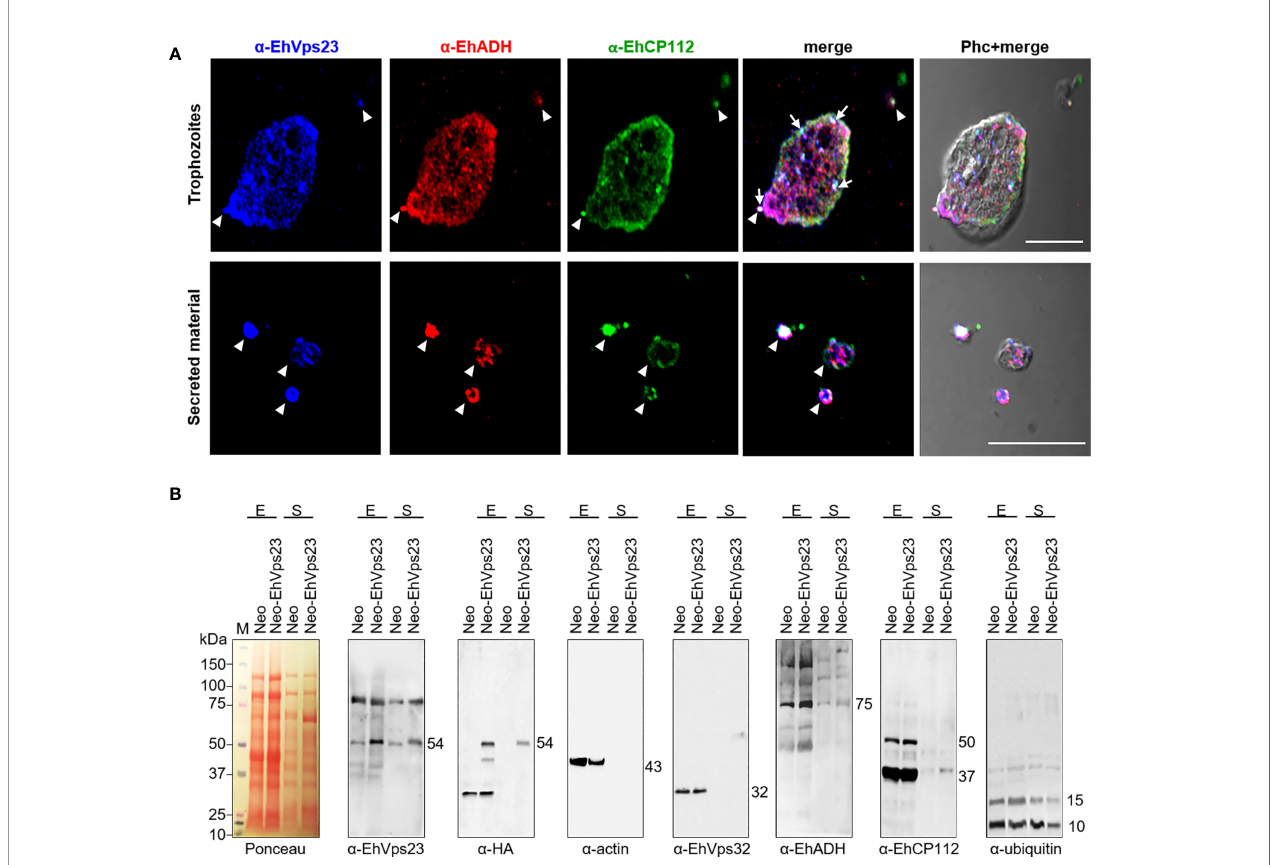
FIGURE 5 | Immunodetection of EhVps23 in Neo-EhVps23 and Neo trophozoites and in the secreted products by trophozoites. (A) Confocal images of trophozoites and their secreted products treated with a -EhVps23, a -EhADH, a -EhCP112 antibodies and fl uoresceinated secondary antibodies, according to the specie of each one of the antibodies used. Scale bar = 10 m m. (B) Ponceau stain and western blot of trophozoites extracts (E) and their secretion products (S) separated by SDS-PAGE and blotted with a -EhVps23, a -HA, a -EhVps32, a -EhADH, and a -Ubiquitin. a -EhCP112 was used as a positive control and a -actin as a control of the absence of trophozoites debris in the